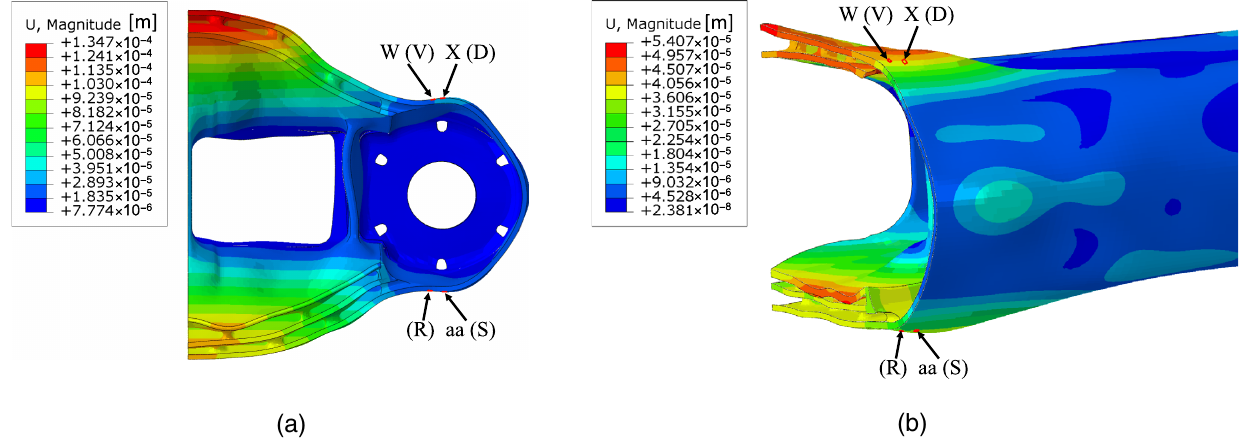
FIG. 14. Simulated deformation of the vessel near the two strain peaks of the sensor (deformation is magnified 500 ×, sensor IDs in parentheses are on the symmetry side). (a) At 0.3 ms and (b) at 0.65